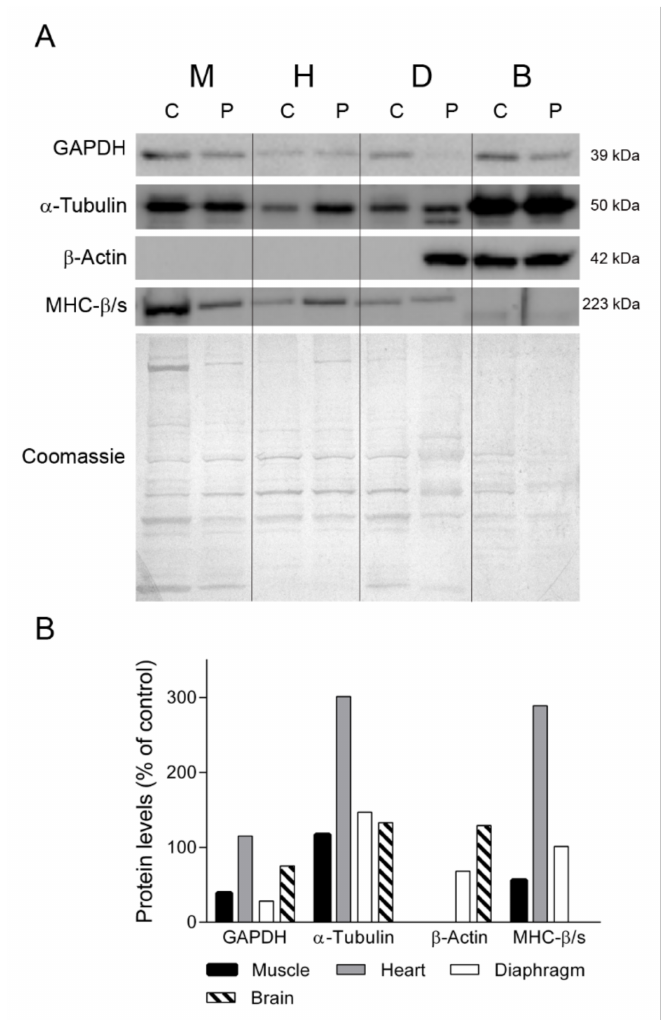
Figure 3. Constitutive proteins. ( A ) Representative western blotting of proteins with constitutive expression in tissue homogenates of a control (C) (n = 3 for muscle, n = 1 for other tissues) and the patient (P). Shown below is a representative Coomassie blue-stained gel. ( B ) Densitometry analysis: protein levels were normalized to total protein loading according to Coomassie blue staining. Data are expressed as percentage of control values. Abbreviations: M, skeletal muscle; H, heart; D, diaphragm; B, brain. GAPDH, glyceraldehyde-3-phosphate dehydrogenase; MHC- β /slow, myosin heavy chain